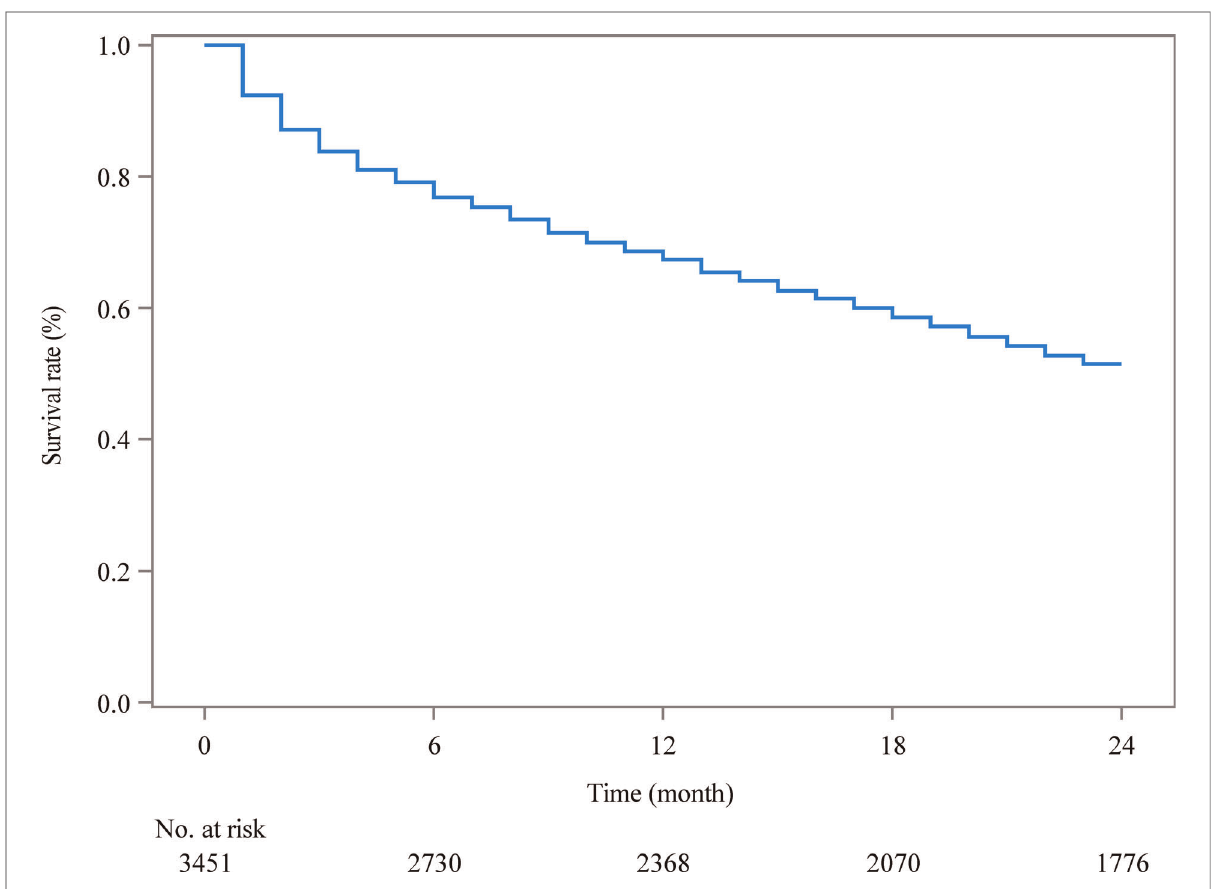
FIGURE 2 The Kaplan-Meier curve estimating 2-year survival of metastatic ovarian cancer patients in the training